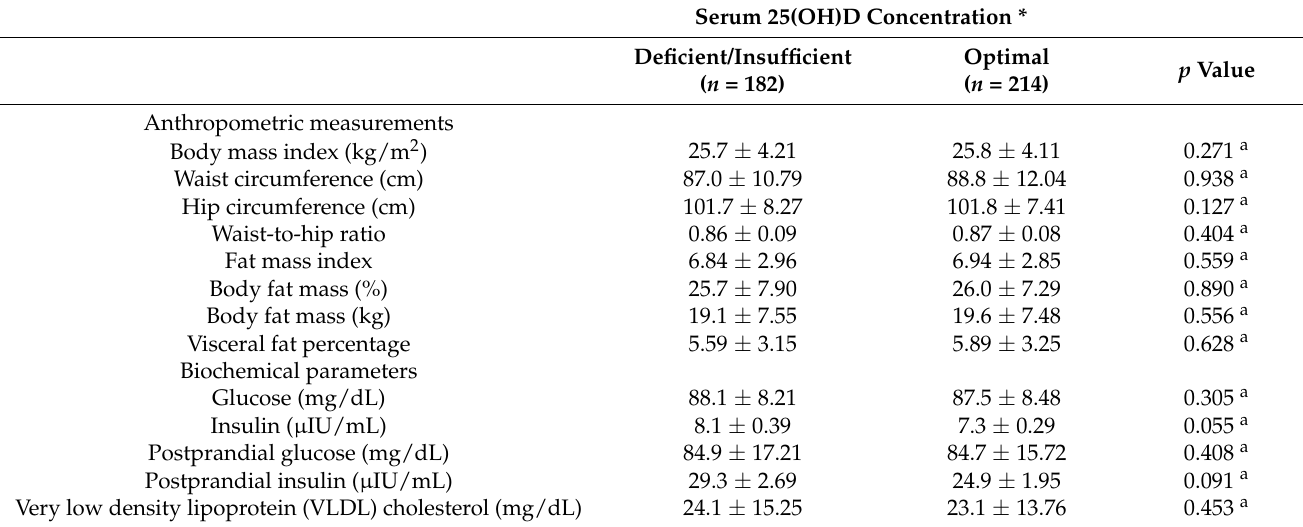
Table 1. Basic characteristics of the study participants according to serum vitamin D